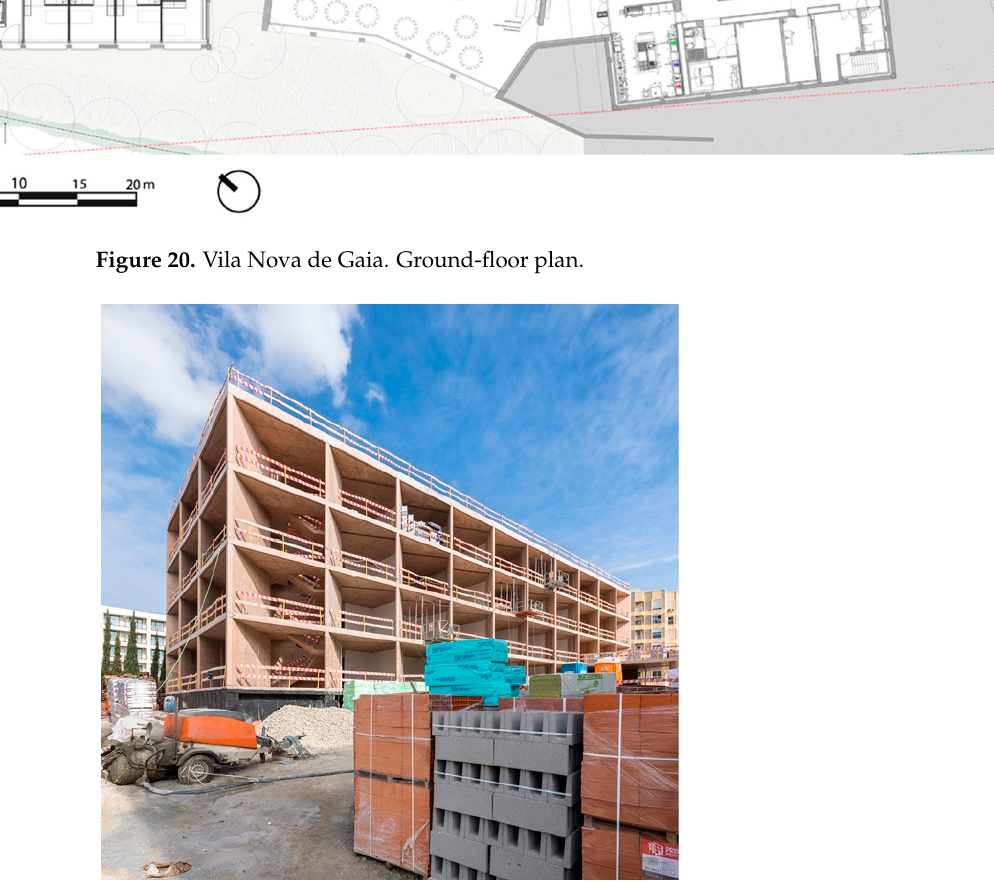
Figure 21. Coimbra. New building. ©João Ferrand.